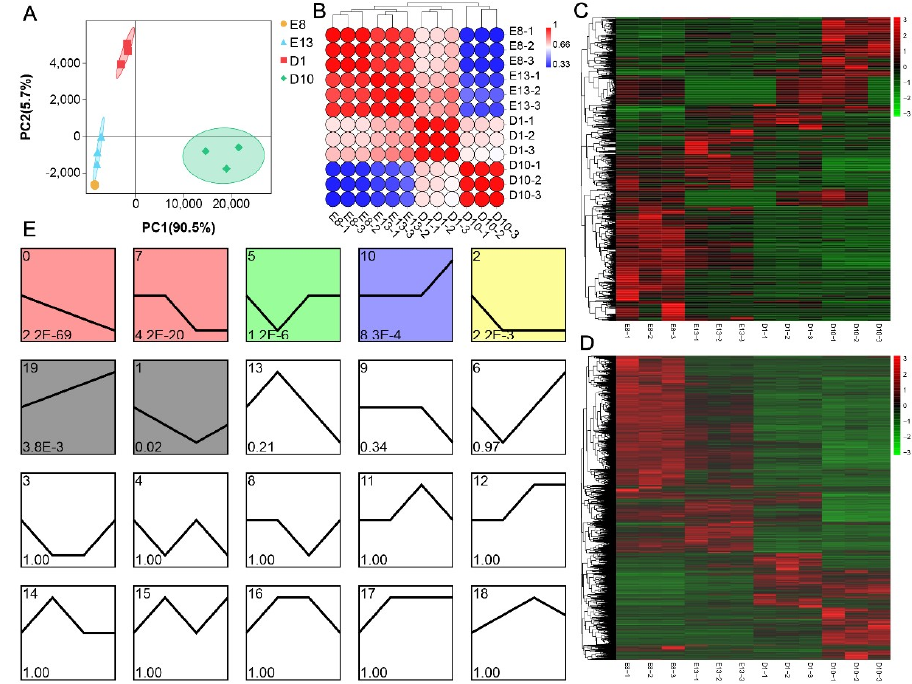
Figure 1. Expression patterns of miRNAs and mRNAs during pigeon skeletal muscle development and growth. ( A ) Principal component analysis (PCA) of the samples based on all miRNA and mRNA expressions. ( B ) Correlation analysis of the samples based on all miRNA and mRNA expressions. The colors from blue to red represent a correlation from low to high. The principal component and correlation analysis indicate distinct expression patterns of miRNA and mRNA at different stages. There were differences among the regulatory mechanisms for the development and growth of skeletal muscle. ( C ) Heatmap of differentially expressed miRNA. ( D ) Heatmap of differentially expressed mRNA. Colors from green to red indicate expression levels from low to high. ( E ) Expression profiles analysis of all miRNA by Short Time-series Expression Miner (STEM) program. A total of 20 profiles were clustered. Colored profiles were significant ( p -value <